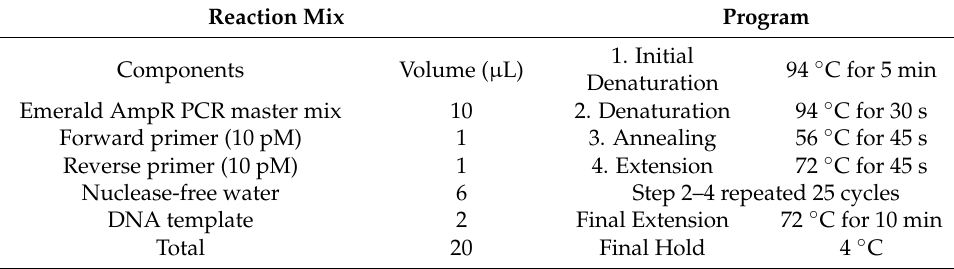
Table 1. PCR Components and reaction conditions used in the present